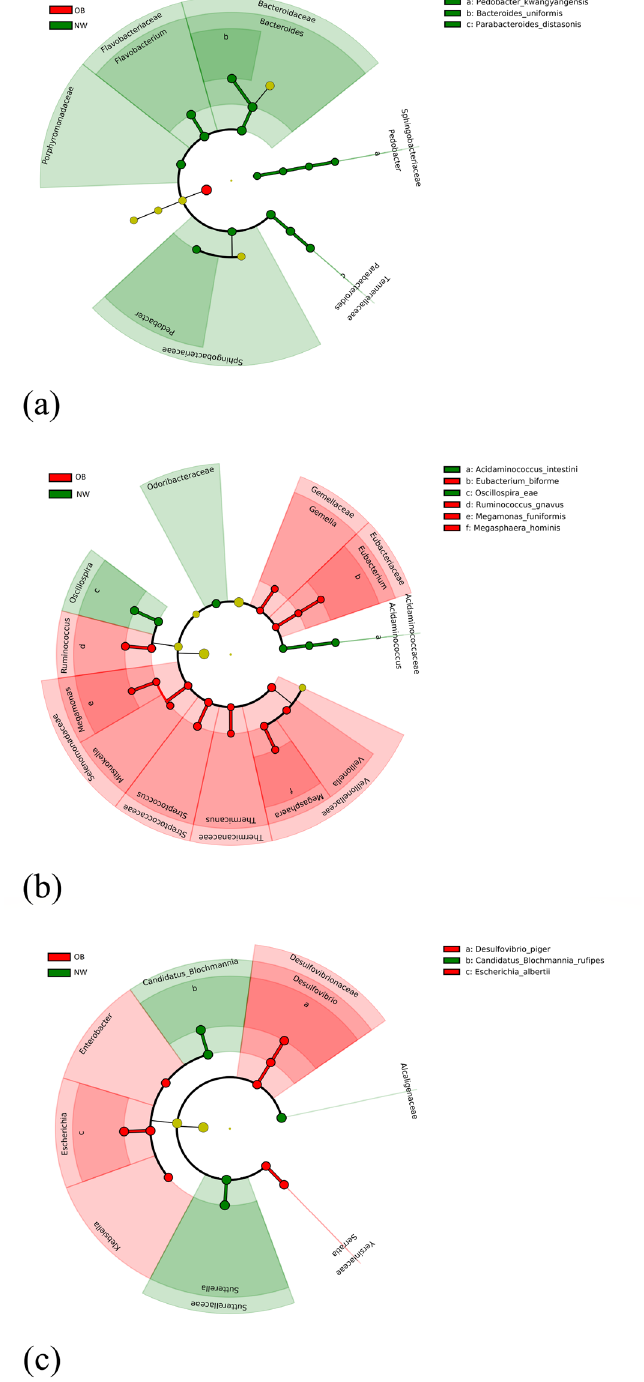
Figure 4. Linear Discriminant Analysis Effect Size (LEfSe) cladogram of microbial taxa between OB and NW. LEfSe algorithm was performed on Galaxy computational tool v.1.0. (https ://hutte nhowe r.sph.harva rd.edu/galax y/). The diameter of each circle is proportional to the abundance of the taxon. Only the differentially abundant taxa at the different taxonomic ranks were indicated. Red bacterial taxa were more abundant in OB; green bacterial taxa were more abundant in NW. NW = normal-weight healthy controls, OB = overweight and obese patients; ( a ) Bacteroidetes phylum, ( b ) Firmicutes phylum, ( c ) Proteobacteria